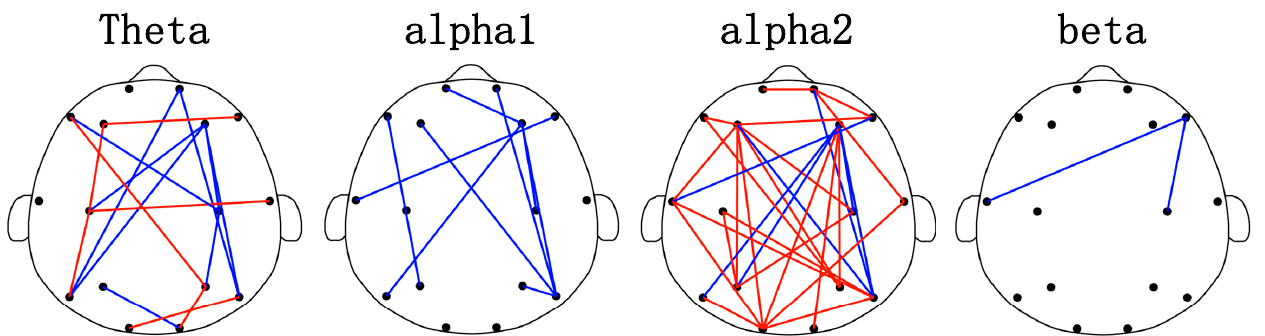
Figure 2. Brain function network topology of HGAD and LGAD in theta, alpha1, alpha2, beta rhythms. The red edge indicates that HGAD has a higher weight on the edge. The blue edge indi- cates that LGAD has a higher PLI value.